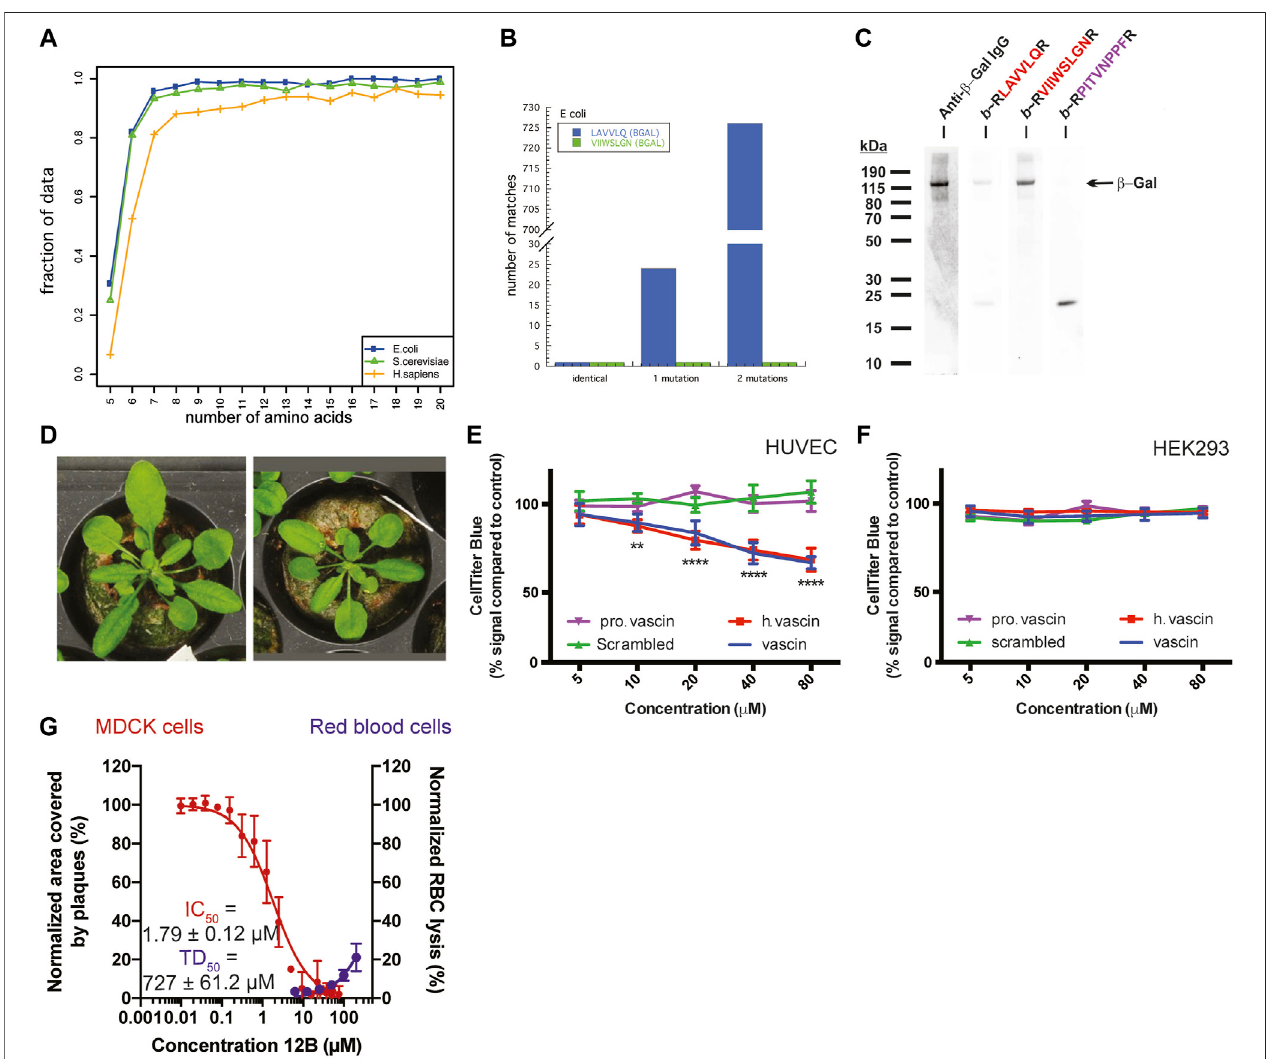
FIGURE 2 | (A) The fraction of APRs that are unique within the E. coli , S. cerevisiae , or H. sapiens proteome, plotted by length of the APR. (B) The number of sequences in the E. coli proteome that match two peptides derived from β -galactosidase (allowing 0, 1, or 2 substitutions). (C) Detection of β -Galactosidase in bacterial cell lysates with immunoblotting using speci fi c antibody (lane 1) or with PepBlot using sequence-speci fi c peptides(lanes 2 – 4) ( A – C adapted from Ganesan et al., 2015). (D) Arabidopsis plants expressing a Pept-In targeting the negative regulator of brassinosteroid signaling (left) grow larger than wild type plants (right) . Adapted from Betti et al., 2016. (E,F) Dose-dependent toxicity of vascin, its human counterpart (h vascin), and a proline mutant of vascin (pro vascin) or scrambled version as controls (from 2.5 to 100 mm) by the CellTiter-Blue assay. (E) Vascin and h.vascin are toxic to HUVEC cells that depend on VEGFR signaling for survival but not to HEK293 cells (F) ( E,F adapted from Gallardo et al., 2016). (G) Dose-dependent effect of an antiviral peptide (12B) targeting an APR in the cap-binding domain of polymerase basic protein 2ofthe in fl uenza Avirus. TreatingMDCK cells infected with in fl uenza A ledtoa dose-dependent decrease ofthe areacovered byviral plaques (redcurve,leftaxis)withanIC50below2 μ m.Dataarenormalizedtobuffer-treatedcellsandthemean ± SDof4independentexperimentsisshown.Peptide12Bdidnot havesigni fi canthemolyticactivity (bluecurve,rightaxis).Fortoxicdose(TD50):dataarenormalizedtobuffer-treated(0%lysis)and0.1%Triton-treated cells(100%lysis) and the mean ± SD of 3 independent experiments is shown. ( G Adapted from Michiels et al.,